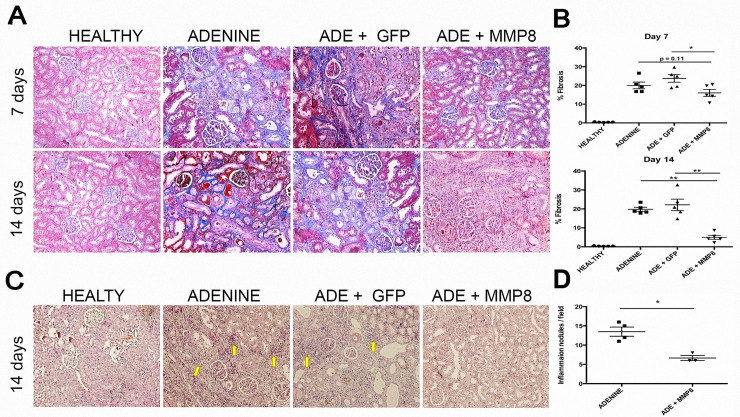
Assessment of kidney fibrosis and inflammation.A) Masson staining showed morphological tissue alteration in Adenine group with established fibrosis. Animals treated with AdhMMP8 vector showed a significant marked reduction of fibrotic tissue at both cohort times. B) Graphs showed percentage of fibrosis in renal tissue according to software analysis of representative images. Fibrosis is notably reduced in AdMMP8 groups, especially at day 14 after adenoviral administration. ** p<0.01, * p<0.05. C) Adenine group H&E staining showed granulomas formation and inflammatory cell infiltrates. Also, zones of tubular atrophy with interstice expansion as a consequence of fibrosis and mononuclear inflammatory cell nodules were noted. A decrease of inflammatory cells, fibrotic tissue and inflammatory nodules (yellow arrows), was clearly seen 14 days after AdhMMP8 administration. Likewise, treated animals revealed a decrease in interstitial fibrosis and improvement in tissue architecture and tubular structure. D) Graph showed the quantification of the renal inflammatory cell foci. *p<0.05.